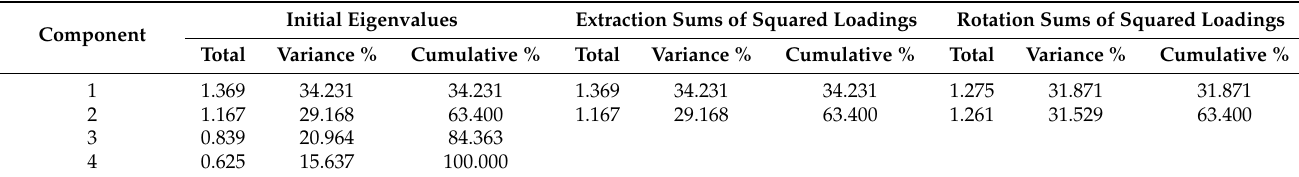
Table 2. Eigenvalues and variances explained with extracted factors of household infrastructure